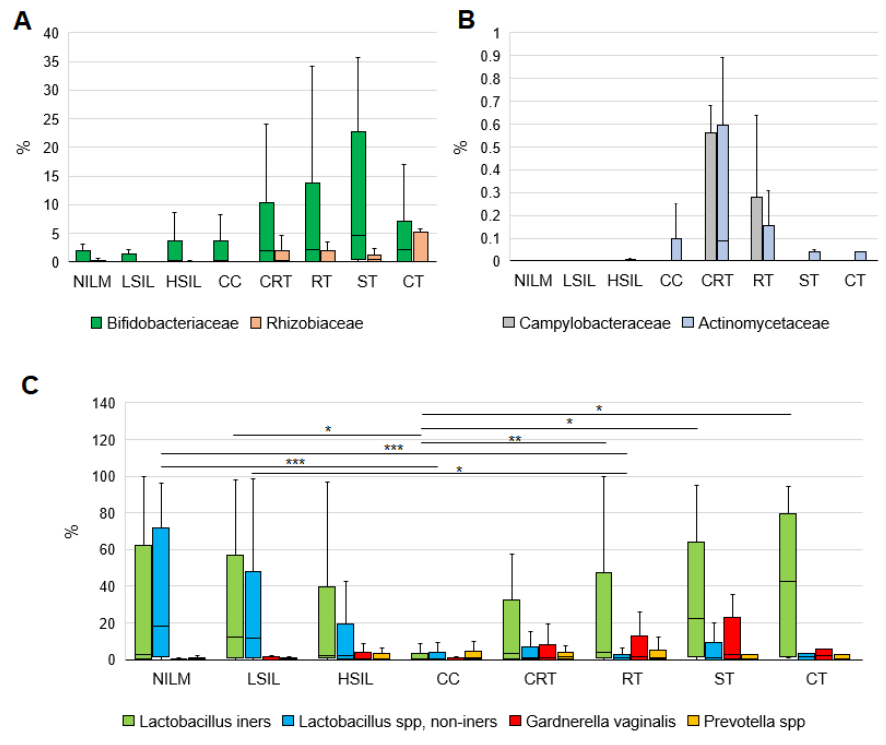
Figure 7. ( A ) Relative abundance counts of the highly abundant families that were found by LDA to be most significantly over-represented in the PT group. ( B ) Relative abundance counts of the low-abundance families that were found by LDA to be significantly over-represented in the PT+ vs. PT- group. CRT, chemoradiotherapy; RT, radiotherapy; ST, surgical treatment; CT, combined therapy. ( C ) Enrichment with Lactobacillus iners , non-iners lactobacilli, Gardnerella vaginalis , and Prevotella species at different diagnoses and in PT subgroups. Differences between groups were assessed by the Mann–Whitney U test with the Bonferroni correction for multiple testing; an adjusted p -value was calculated as a pairwise nonadjusted p -value multiplied by the total number of comparisons. The figure presents the median value, upper and lower quartiles, and a nonoutlier range; outliers are not shown. *** p ≤ 0.001; ** 0.001 < p < 0.01; * p < 0.05.